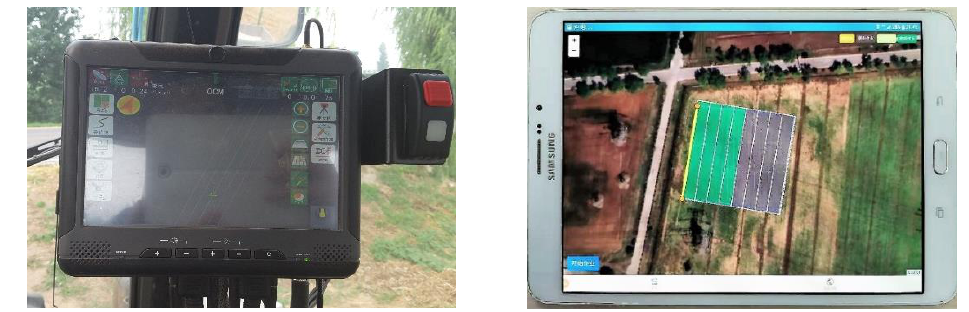
Figure 9. The NX200 auto-steering system for a John Deere 1204 tractor and the Android-based application for a T715C tablet.